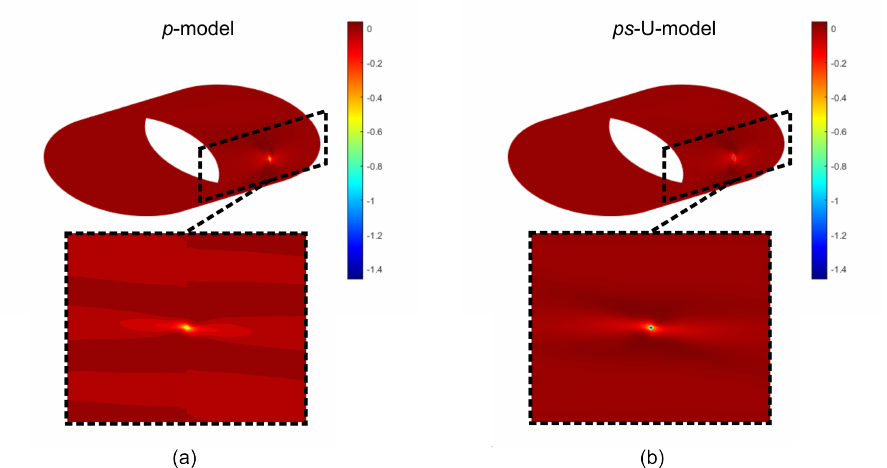
Figure 21. Variable stiffness cylindrical elliptical shell: stress field σ 22 : ( a ) p − model and ( b ) ps − U − model.